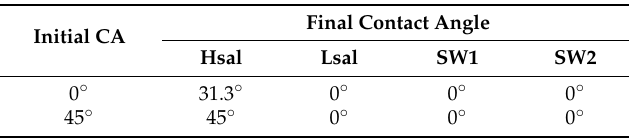
Table 4. Contact Angle values of the non-aged calcite surfaces in oil (Case 1 = strongly water wet and Case 2 = preferentially water wet).